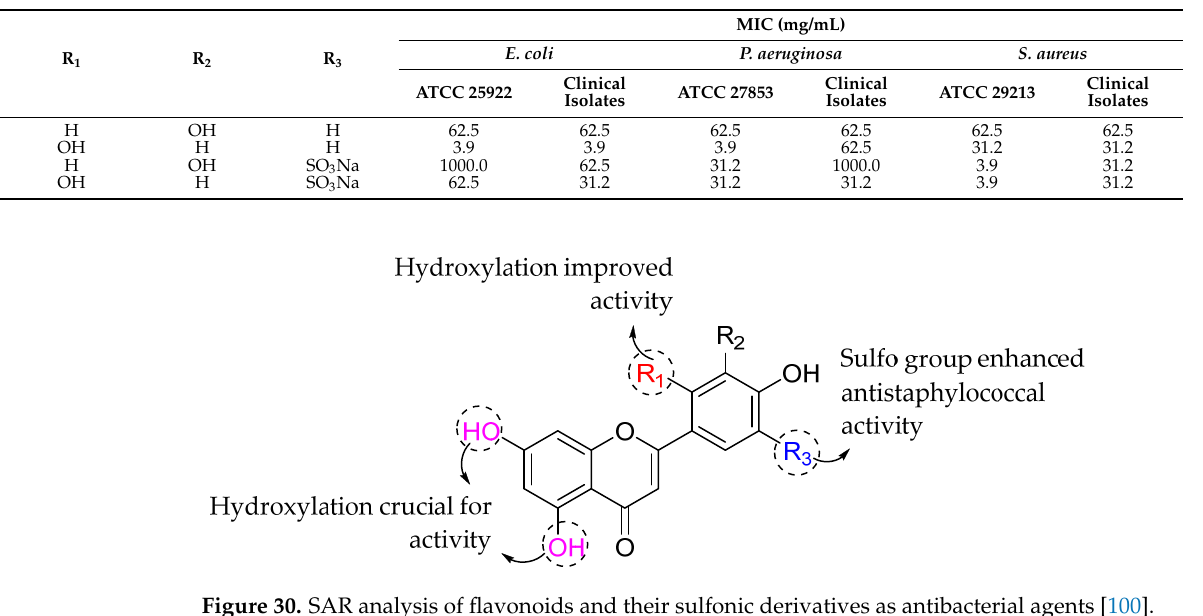
Table 20. Antibacterial activities of flavonoids and their sulfonic derivatives against several bacterial pathogens.